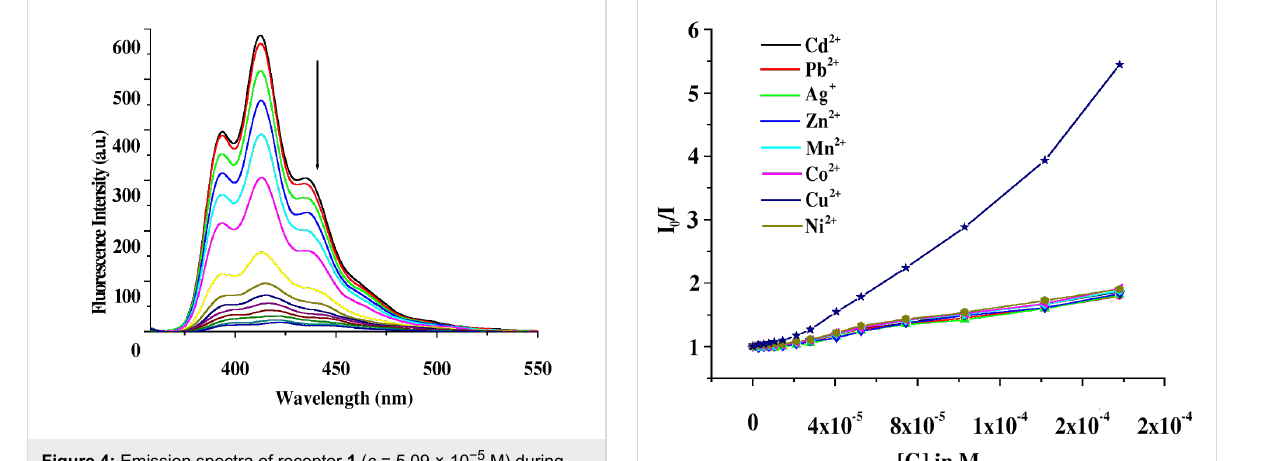
Figure 4: Emission spectra of receptor 1 ( c = 5.09 × 10 − 5 M) during titration with Cu 2+ ion ( c = 1.4 × 10 − 3 M) in CH 3 CN containing 0.02% DMSO ( λ ex = 348 nm).